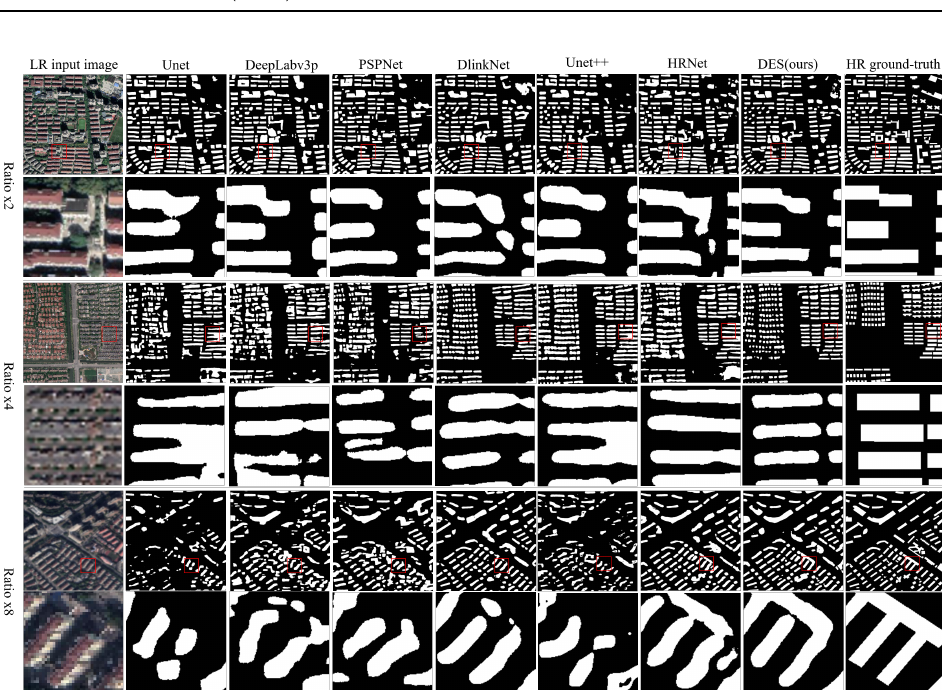
Figure 6. Qualitative examples of segmentation results of each method with ratio factors of 2, 4, and